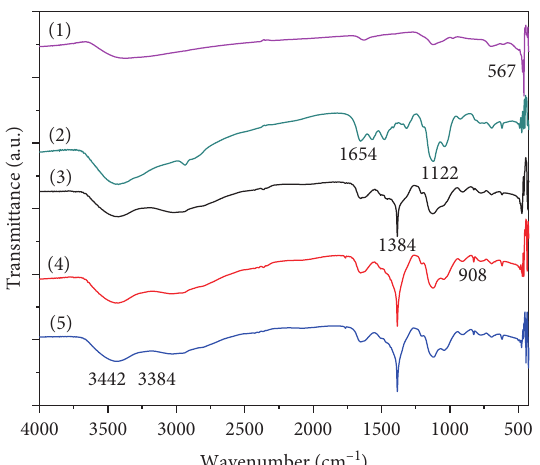
Figure 1: FTIR spectra of (1) ferric oxide, (2) fresh ferric oxide-amine, and used ferric oxide-amine after (3) nitrate adsorption, (4) phosphate adsorption, and (5) simultaneous nitrate and phosphate